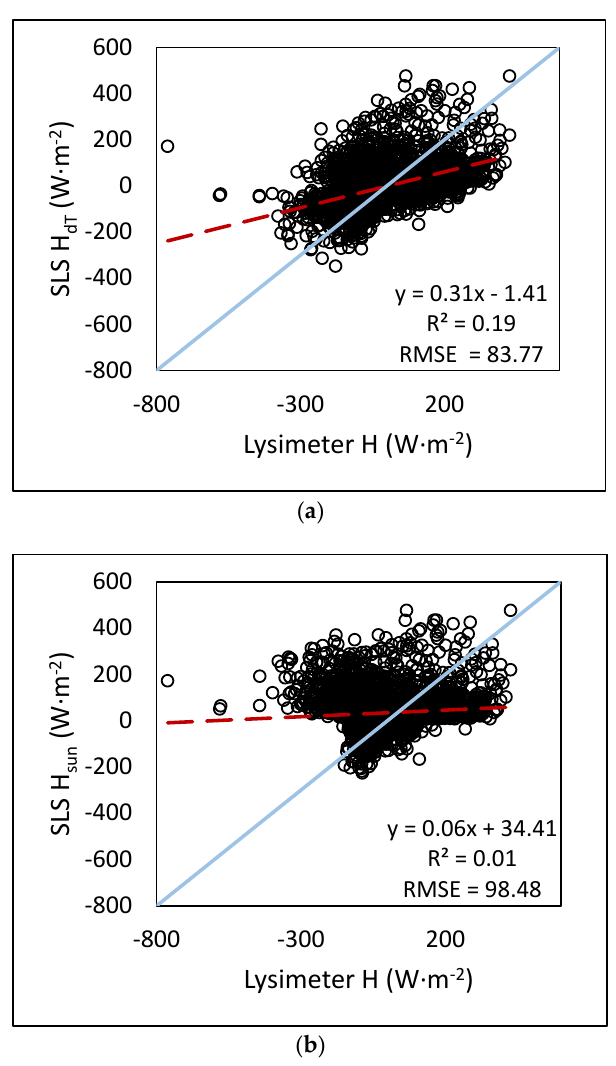
Figure 6. Comparison of hourly H dT and H sun from the SLS to lysimeter H for the combined 2015–2016 data based on lysimeter data regressed to ( a ) H dT ; ( b ) H sun .